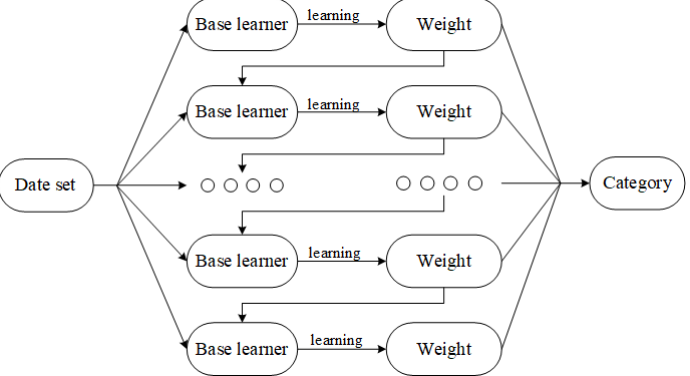
Figure 7. The construction of GBDT